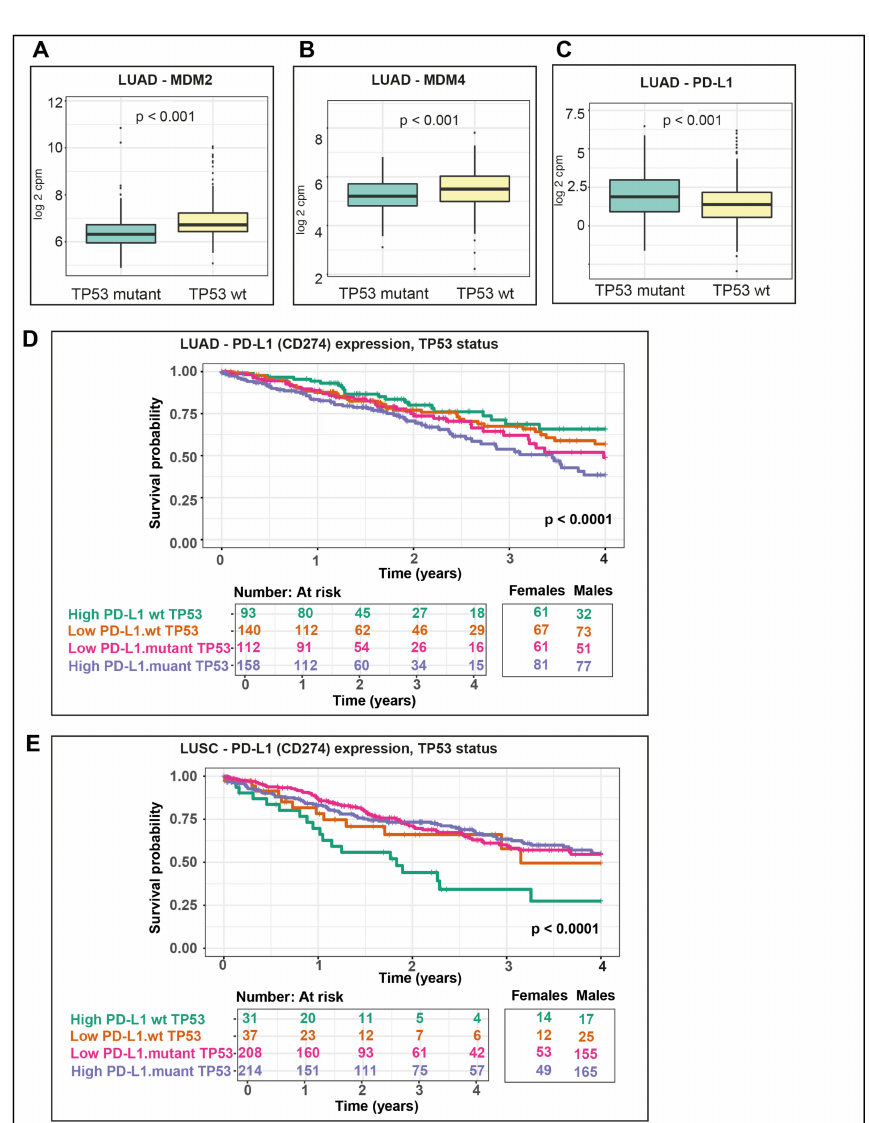
Figure 8. TP53 regulators and immune gene targets are expressed distinctly in LUAD and LUSC. In LUAD with wt TP53, expression is higher for its negative regulators ( A ) MDM2 and ( B) MDM4, compared to those with mutant TP53. ( C ) PD-L1 expression is higher in LUAD mutant TP53 compared with wt TP53. Propensity scores were included and significance is p < 0.05. Survival di ff ered between patients according to TP53 mutation status and PD-L1 expression levels in ( D ) LUAD and ( E )